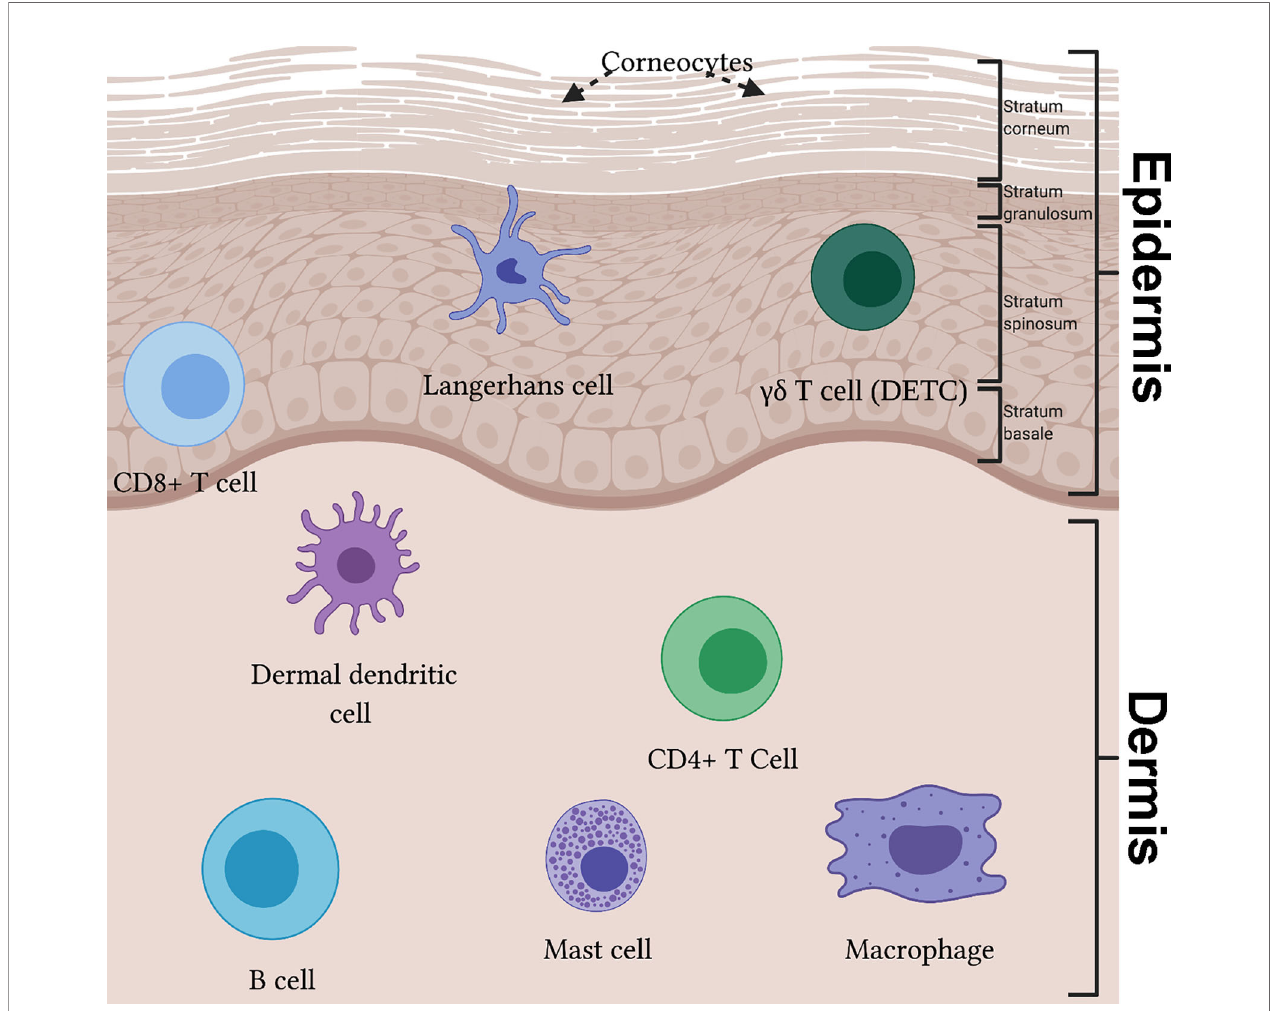
FIGURE 2 | The immune system of the skin reveals a diverse population in effector immunocytes. The epidermis can be divided into four layers, from super fi cial to deep: stratum corneum, stratum granulosum, stratum spinosum and stratum basale. In the epidermis, Langerhans cells partake in antigen presentation and migration to lymph nodes. gd T cells, also known as dendritic epidermal T cells (DETCs), are key cytokine producing cells in mice skin. Cytotoxic CD8+ T cells can be found in the deep epidermis. Within the dermis resides many specialized immune cell populations, including dermal dendritic cells, CD4+ T cell subsets (e.g. Th1, Th2, Th17 and T follicular helper) and B cells. Additionally, mast cells and macrophages are